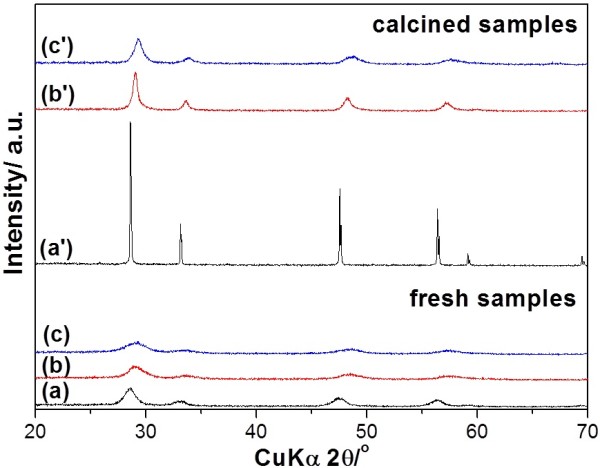
XRD patterns of fresh and calcined samples. Fresh samples: (a) CeO2, (b) Ce0.5Zr0.5O2, and (c) Ce0.5Zr0.3Al0.2O1.9. Calcined samples: (a') CeO2, (b') Ce0.5Zr0.5O2, and (c') Ce0.5Zr0.3Al0.2O1.9.